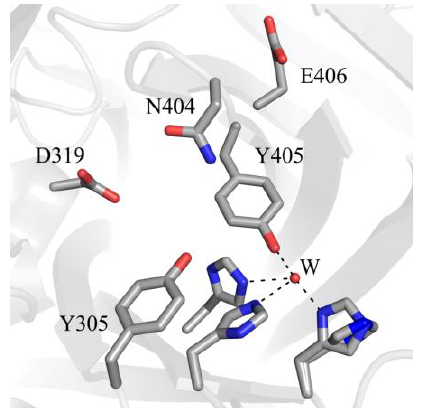
Figure 7. Amino acid residues in apoHPAO-1 shown to be involved in stabilizing biogenesis intermediates (PDB code 3sx1) [71]. Residues are drawn in stick and colored by atom type (carbon, grey). A water molecule is drawn as a small red sphere. Dashed lines indicate hydrogen